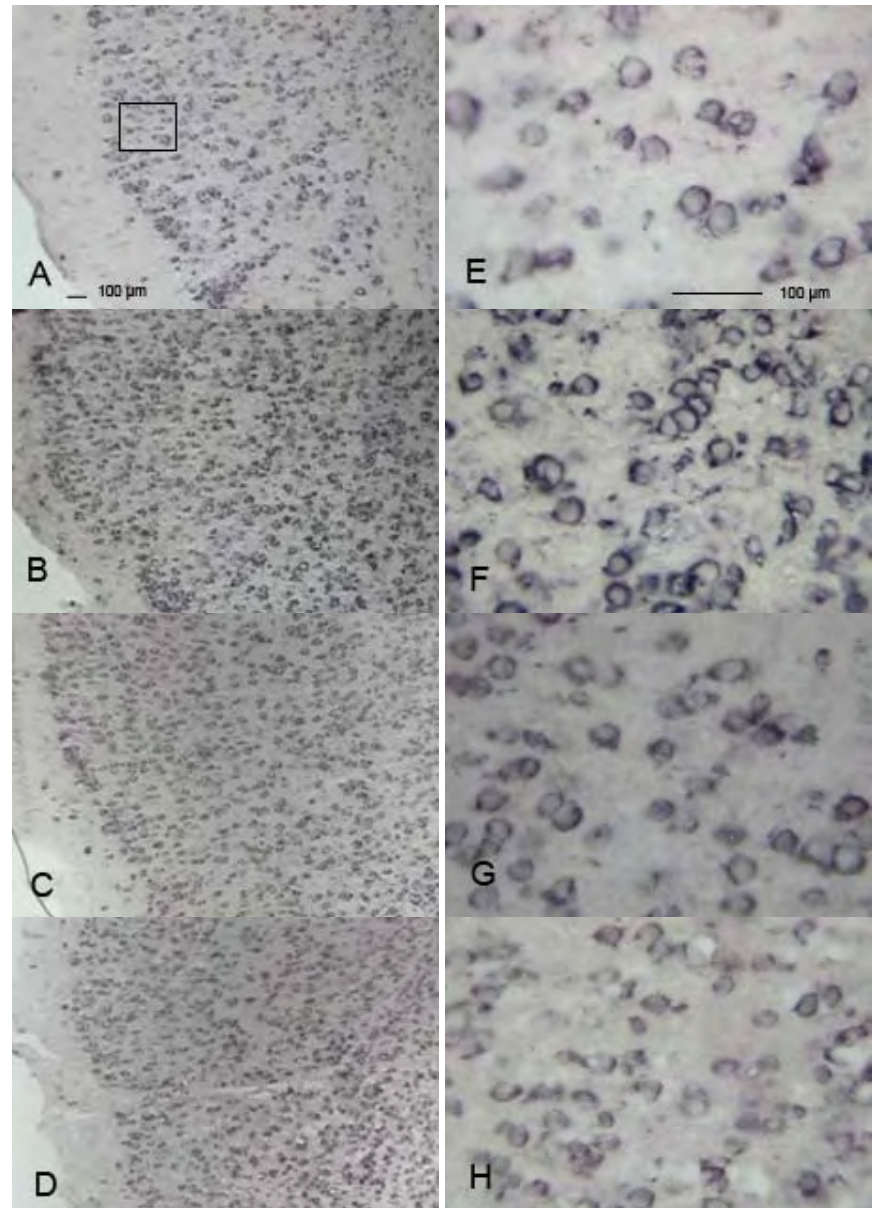
Figure 3 . Effects of daidzein on the expression levels of bcl-2 mRNA assessed by non- radioactive in situ hybridization in D-gal-treated mice cortexes. (A) Aging control. (B) Vehicle control. (C) Da-10 group. (D) Da-5